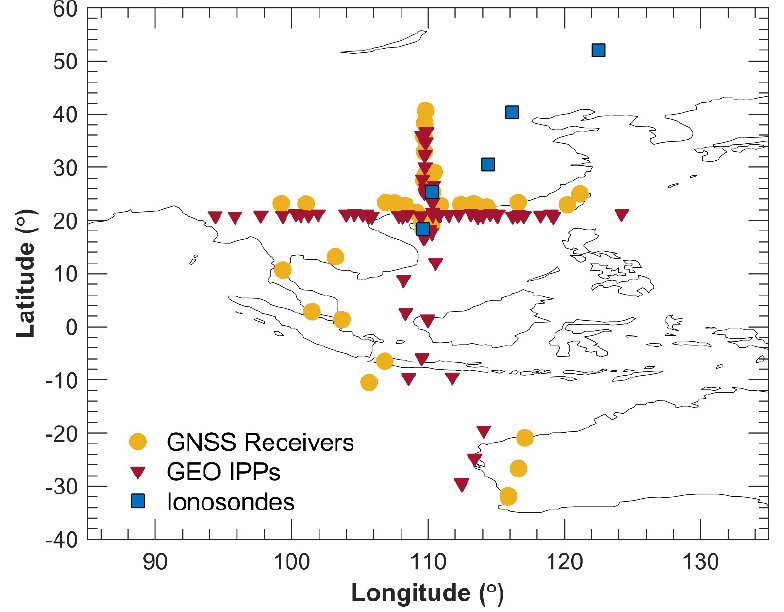
Figure 1. Locations of the ionosondes (blue squares) and GNSS receivers (yellow dots) used in this study. Red triangles mark the ionospheric piercing points (IPPs) of BeiDou GEO satellites paired with GNSS receivers.